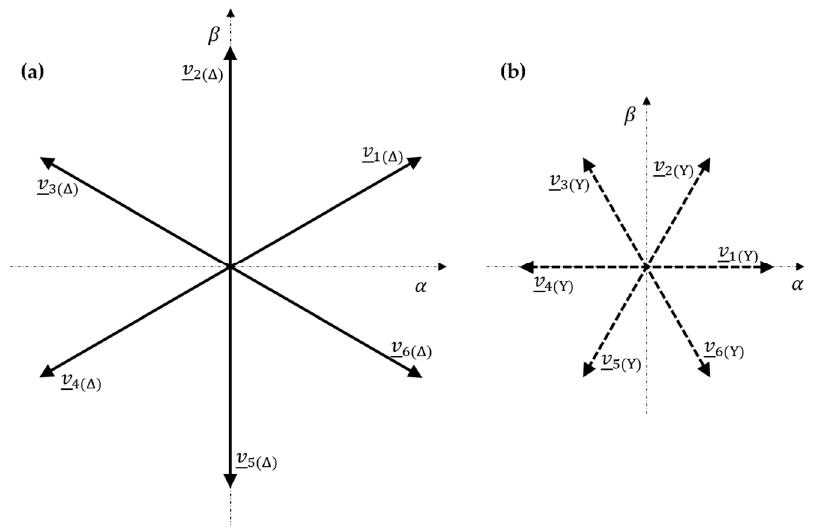
Figure 3. Six active voltage vectors in the stator-fixed 𝛼𝛽 system: ( a ) delta-connected winding; ( b ) star-connected winding.